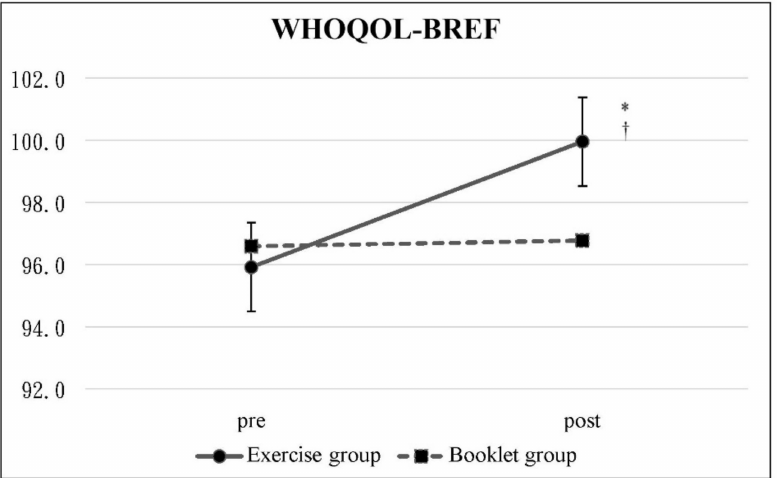
Figure 4. WHOQOL-BREF: Mean scores with 95% confidence intervals at the pretest and posttest. † Significant difference between pretest and posttest in the exercise group. * Significant difference between the two